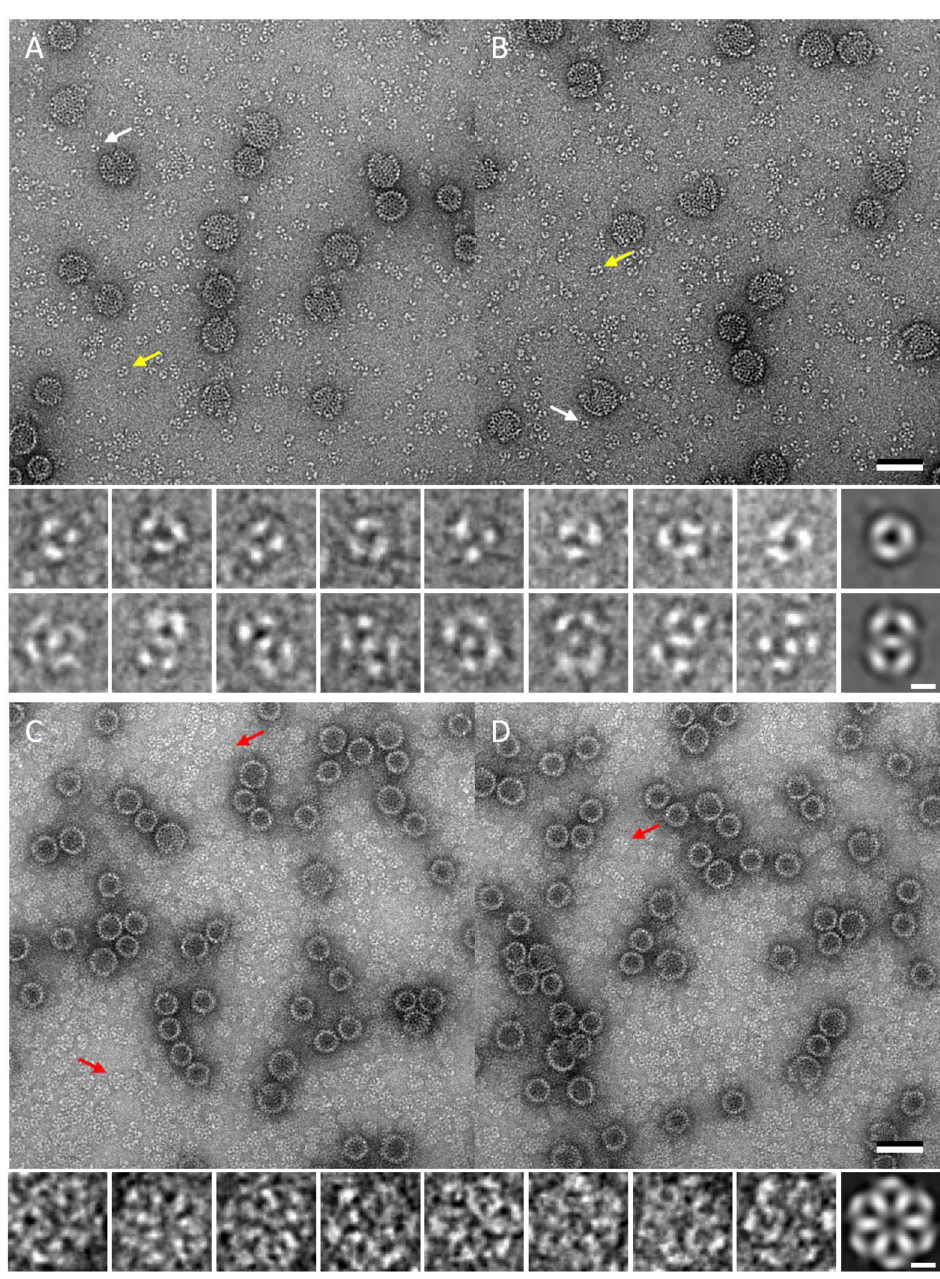
Fig 8. Products of assembly reactions as visualized by negative stain electron microscopy. (A, B) Under mild assembly conditions, core-antigen dimers form small complexes that appear to be trimers-of-dimers (white arrows) and pentamers-of-dimers (yellow arrows). Enlargements and class averages (right) are shown below. (C, D) At later times, six-fold symmetric structures (red arrows) that appear to consist of 12 dimers are formed. Enlargements and a class average (right) are shown below. Under non-assembly conditions, no structures are formed. Bar = 50 nm on main panels, 5 nm on